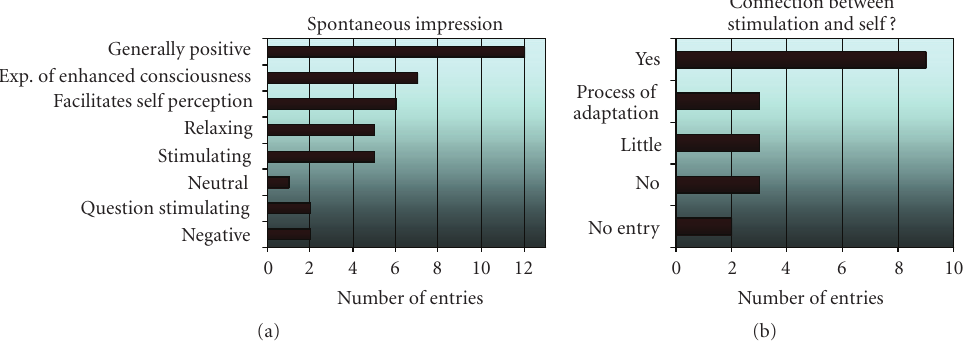
Figure 6: (a) Categorized responses to the spontaneous impression of the participants directly after a session. (b) Answers regarding the connection between the stimulation and the self.